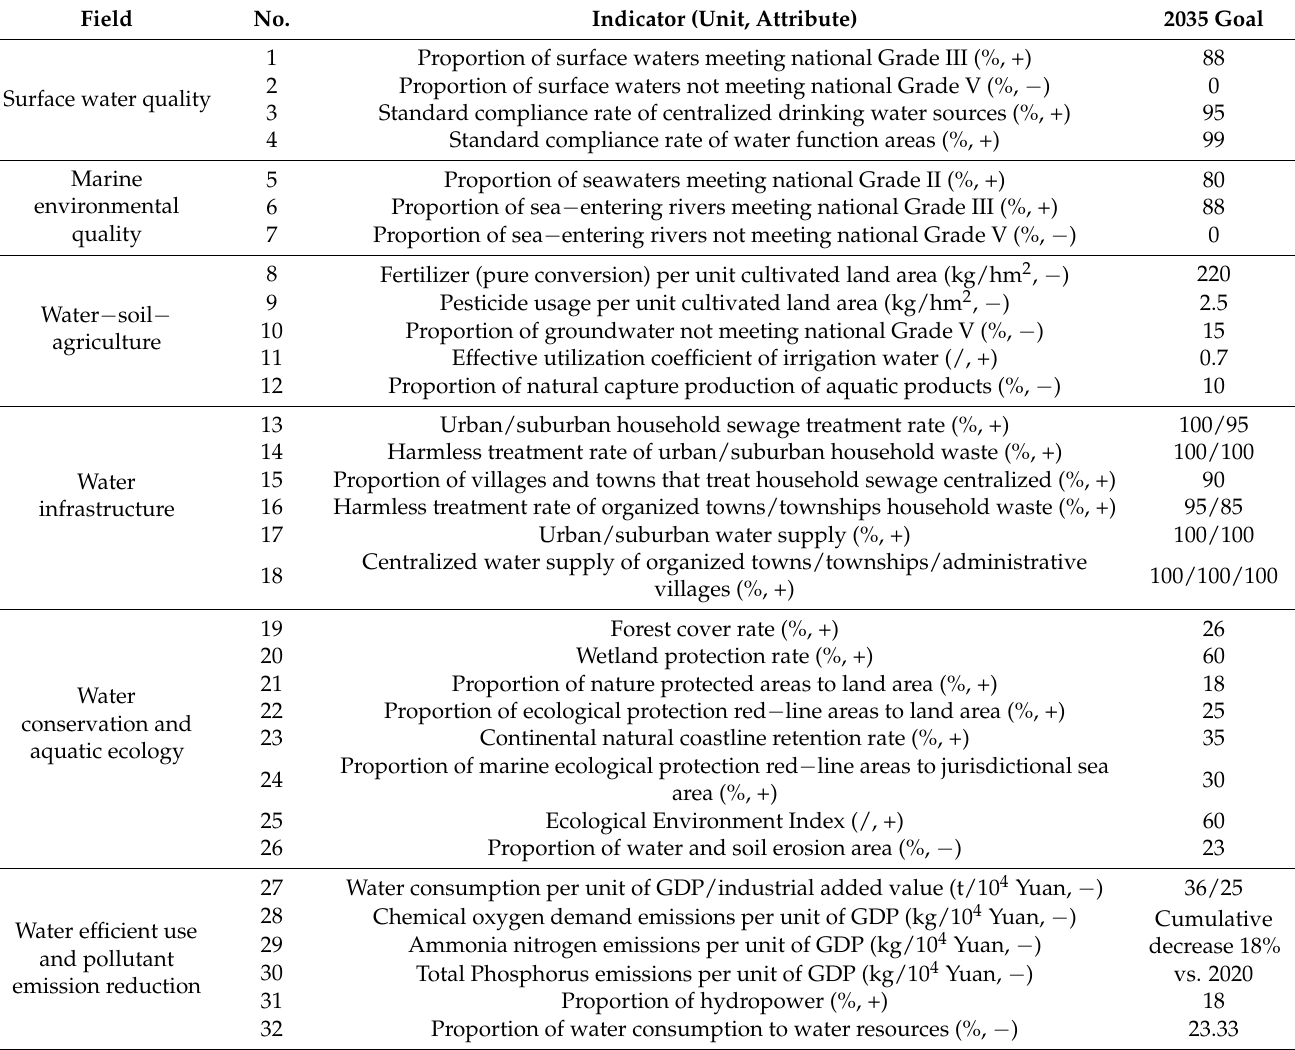
Table 1. The water sustainability evaluation indicator − goal